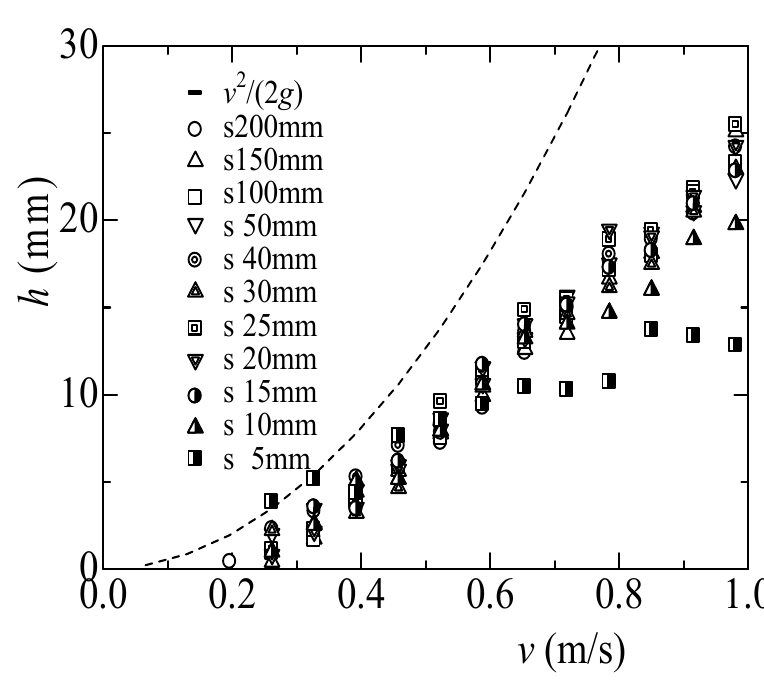
Fig. 6. The relationship between the flow velocity and the height of water surface .